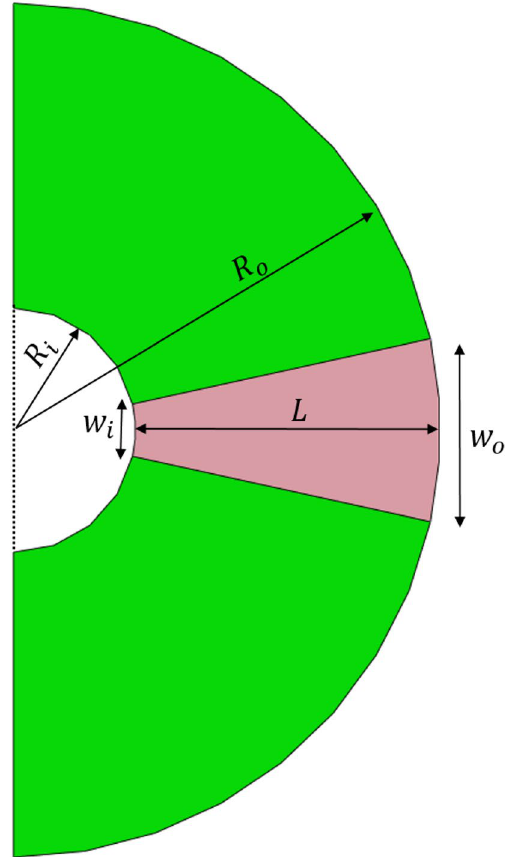
Figure 1. Schematic illustration of the geometric parameters involved in the design of cylindrical hyperlens. For the sake of brevity, a single fin is shown.